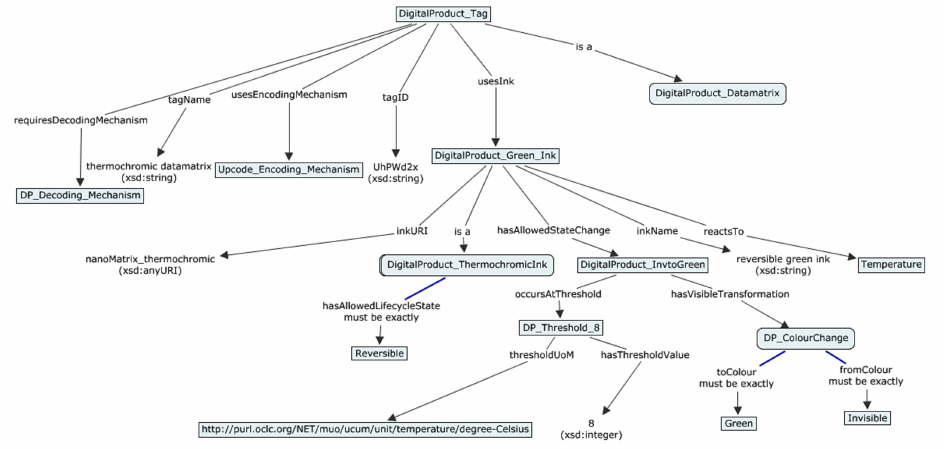
Figure 23. Semantic model for digital product use case with beer.